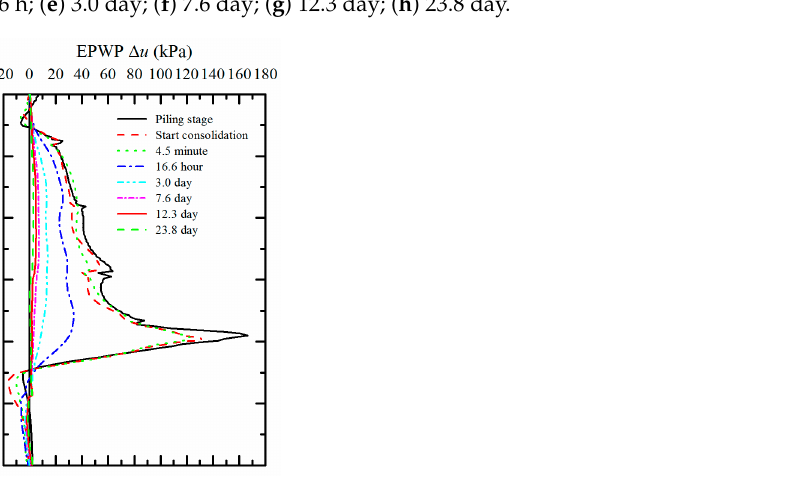
Figure 7. Relationships between EPWP and depth during piling stage and at different times after end of pile jacking. Taking a distance of 0.2 m from the pile wall as an example, Figure 8a shows time histories of EPWP at different depths during and after pile installation. The depths of 3.0, 4.9, 6.0, and 7.5 m are selected to reflect the trend of EPWP in depth, and the similar trends are observed at any other depths less than z p . During pile jacking, the EPWP increases with pile jacking depth and reaches a maximum when the pile tip is near the selected depth, and once the pile tip passes that, the EPWP decreases rapidly. Similar trends are observed if the selected depths is less than z p . Figure 8b shows the dissipation of normal- ized EPWP ( Δ u / Δ u ic ) after installation at different depths, where Δ u ic is the EPWP at the initial consolidation phase. The dissipation duration of normalized EPWP increases with depth, and the normalized EPWP of shallow soil increases initially before starting to sec- ondly dissipate, which demonstrates that the consolidation occurs as a vertical diffusion of pore fluid. ( a ) ( b ) Figure 8. ( a ) Development and dissipation of EPWPs during and after pile installation at different depths; ( b ) Dissipation of normalized EPWPs after pile installation at different depths. Taking a depth of 7.5 m as an example, Figure 9a presents the time histories of EPWP at different distances from the pile wall during and after pile installation. The distances of 0.2, 0.6, 0.9, 1.2, and 2.0 m from the pile wall are selected to reflect the trend of EPWP in radial direction. During pile jacking, the EPWP decreases with the distance from the pile wall. Figure 9b shows the dissipation of the normalized EPWP ( Δ u / Δ u ic ) after installation